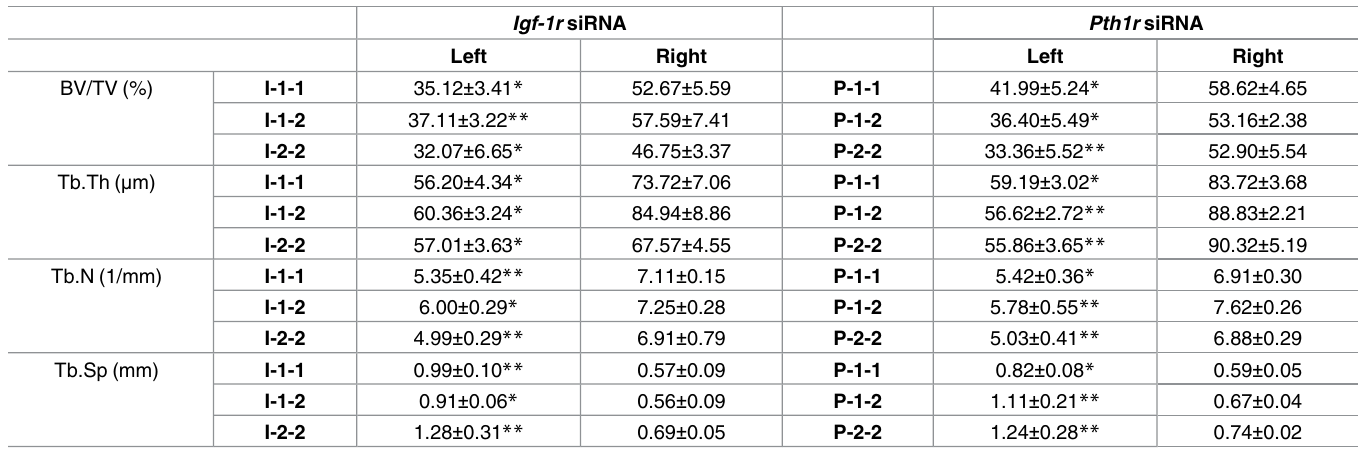
Table 3. Quantitative μ CT Analysis of Tibial Microstructural Parameters. Igf-1r siRNA Pth1r siRNA Left Right Left